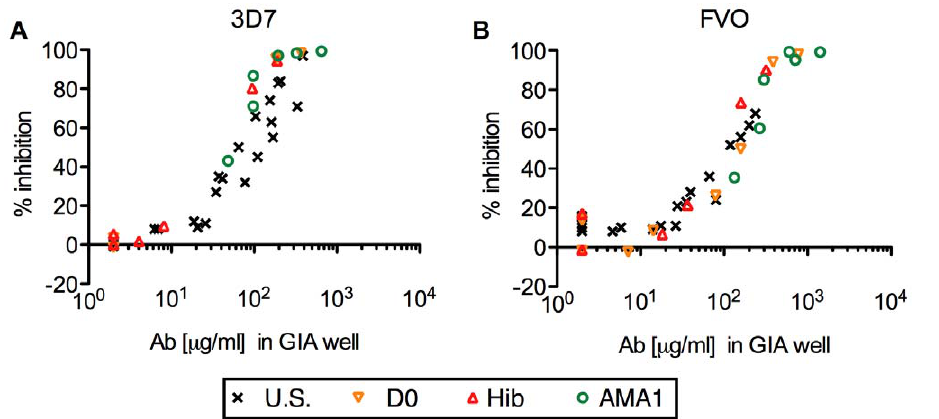
Figure 1. Strong correlation between anti-AMA1 antibody level and the growth-inhibitory activity in AMA1-specific IgGs. Anti- AMA1(3D7) (A) or anti-AMA1(FVO) (B) antibody levels ( m g/ml) in the GIA well ( x -axis) are plotted against % inhibition ( y -axis) of P. falciparum 3D7 (A) or FVO (B) parasites. Each AMA1-specific IgG was tested at three (for U.S. IgGs) or two (for Mali IgGs) different concentrations. All responses below the limit of detection in ELISA were assigned a value of 2 m g/ml for the analysis.